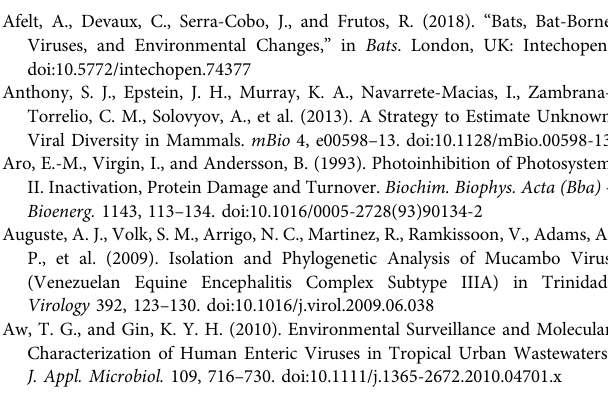
proportions of families recovered using reads translated with blastp. In both methods the RVDB-v21 database reference was used. Figure S4 | Geographic distribution of the metagenomes samples. The different colors indicate the type of host or environment from which the sample was extracted. Figure S5 | Frequency histogram of the length of reads retrieved from all metagenomes. Figure S6 | Frequency histogram of the length of translated contigs retrived from all metagenomes. Figure S7 | Heatmaps of the proportions of contigs classi fi ed into viral families by sample origin. Graphs A and B correspond to the highest proportion (families with > 2%oftotalviralreadsbysample)andlowestproportionofreads(familieswith < 2% of total viral reads by sample). The upper columns represent annotations of the genome and host type of each identi fi ed family. Uncolored boxes correspond to unclassi fi ed families. Genome types are coded as dsDNA, dsRNA, ssDNA(+), ssRNA-RT, ssRNA(+). Their hosts are coded here as A (Animalia), Ar (Archaea), B (Bacteria), C (Chromista), F (Fungi), P (Plantae). Figure S8 | Range of hosts detected by metagenome type.